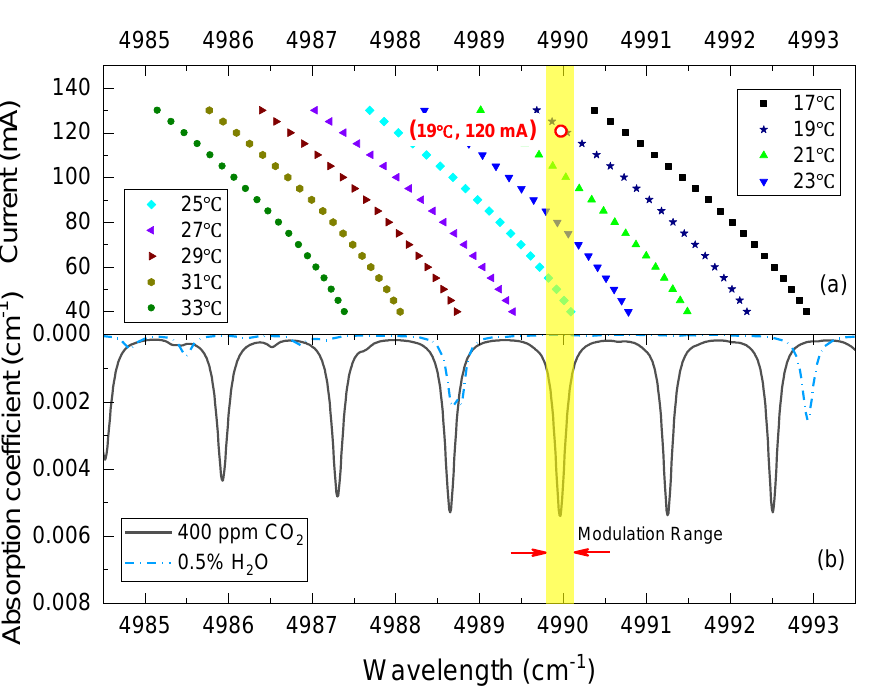
Figure A1. Optimization of driving temperature and bias current. ( a ) DFB laser specification, ( b ) absorption coefficient simulation for 400 ppm CO 2 and 0.5% H 2 O at 296 K and 1 bar. Driving temperature and bias current were selected as 19 ◦ C and 120 mA, respectively, to target the R(16) line of CO 2 at 4989.97 cm − 1 [32]. The yellow shadow depicts the modulation range of ~0.31 cm − 1 . The laser characteristic of a commercial DFB laser near 2.004 µ m is shown in Figure A1a. A spectral range of 4985–4993 cm − 1 can be accessed by adjusting the laser temperature (17–33 ◦ C) and the injection current (40–140 mA). As depicted in Figure A1b, the absorption coefficient of 400 ppm CO 2 and 0.5% H 2 O at 296 K and 1 bar are interrogated based on the HITRAN database. Bias current of 120 mA and temperature of 19 ◦ C (labeled as a red circle) were selected to drive this DFB laser, and a modulation range of ~0.31 cm − 1 (labeled as yellow shadow) was applied, as well. Therefore, the R(16) line of CO 2 with a relatively strong intensity of 1.319 × 10 − 21 cm − 1 · (mol · cm − 2 ) –1 can be interrogated with less